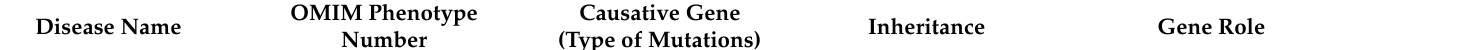
Table 1. Congenital metabolic bone disorders due to altered activity of bone